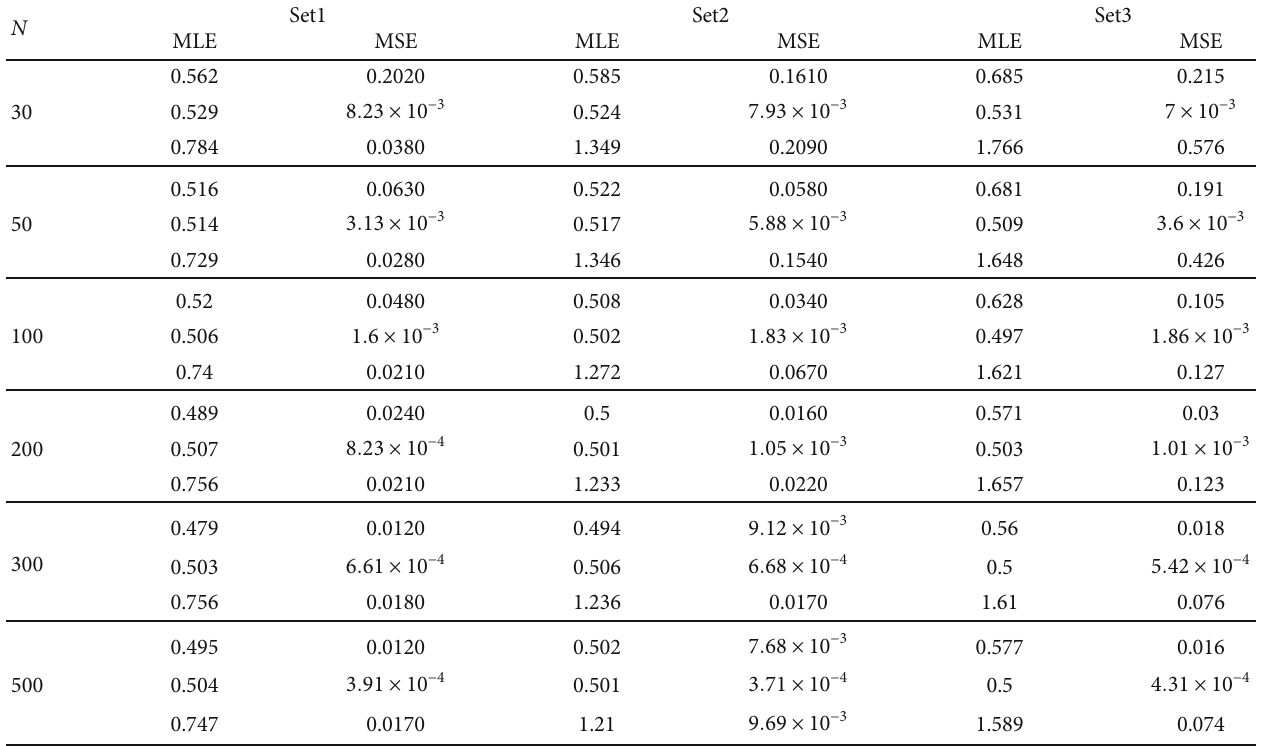
Table 3: The MLEs and MSEs of the APTLL